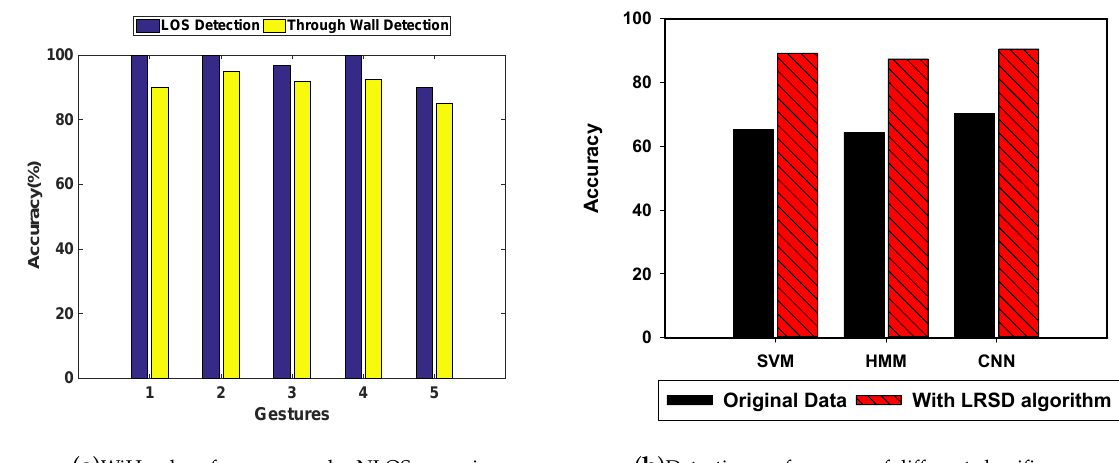
( b ) Detection performance of different classifiers. Figure 14. Detection performance under through the wall